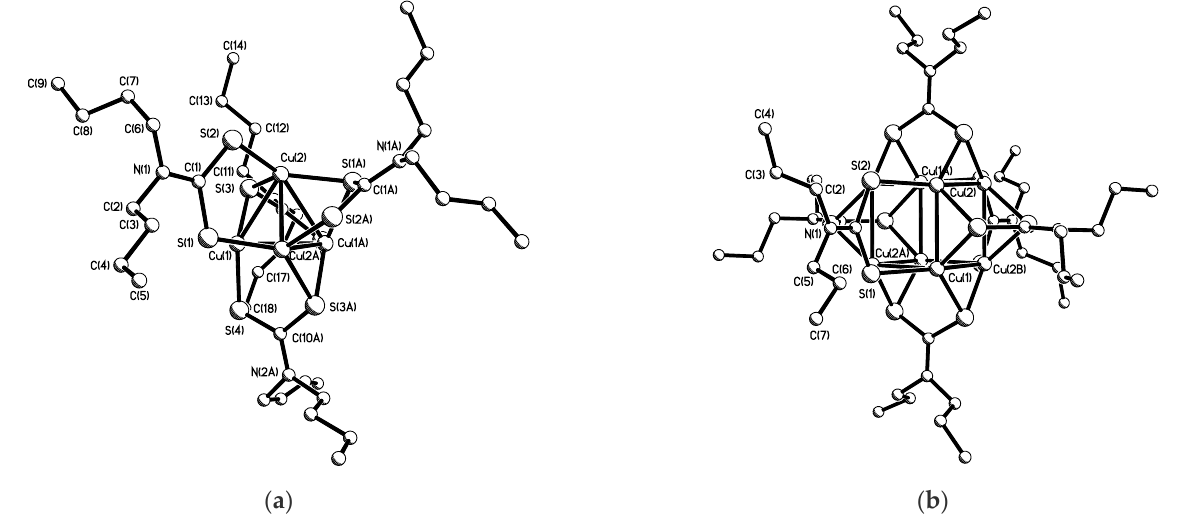
Figure 11. Molecular structures of ( a ) [{Cu( μ 3 -S 2 CNBu 2 )} 4 ] and ( b ) cationic core in [{Cu( μ 4 -S 2 CNPr 2 )} 8 ][ClO 4 ] 2 . Reproduced with permission from [100]. Copyright 2006 Elsevier.